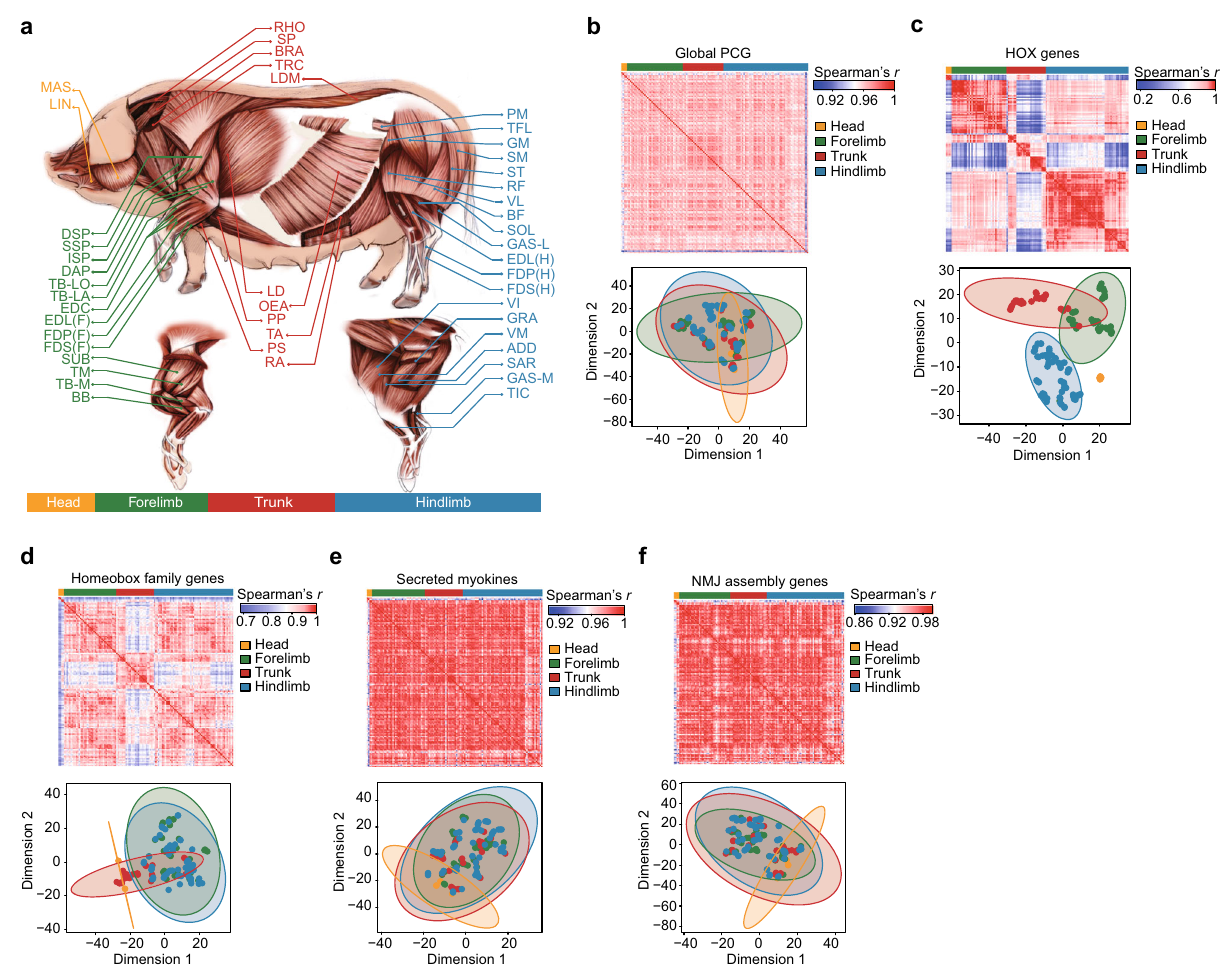
Fig. 3 The transcriptional diversity among SMTs. a Illustration of the anatomical position of SMTs. a A total of 47 types of SMTs were used to compare transcriptional pro fi les between anatomical regions, classi fi ed into four general groups: two head SMTs (orange) (LIN: Lingualis, MAS: Masseter); 14 forelimb SMTs (green) (BB: Biceps brachii, DAP: Deltoideus acromial part, DSP: Deltoideus scapular part, EDC: Extensor digitorum communis, EDL(F): Extensor digitorum lateralis (forelimb), FDP(F): Flexor digitorum profundus (forelimb), FDS(F): Flexor digitorum super fi cialis (forelimb), ISP: Infraspinatus,